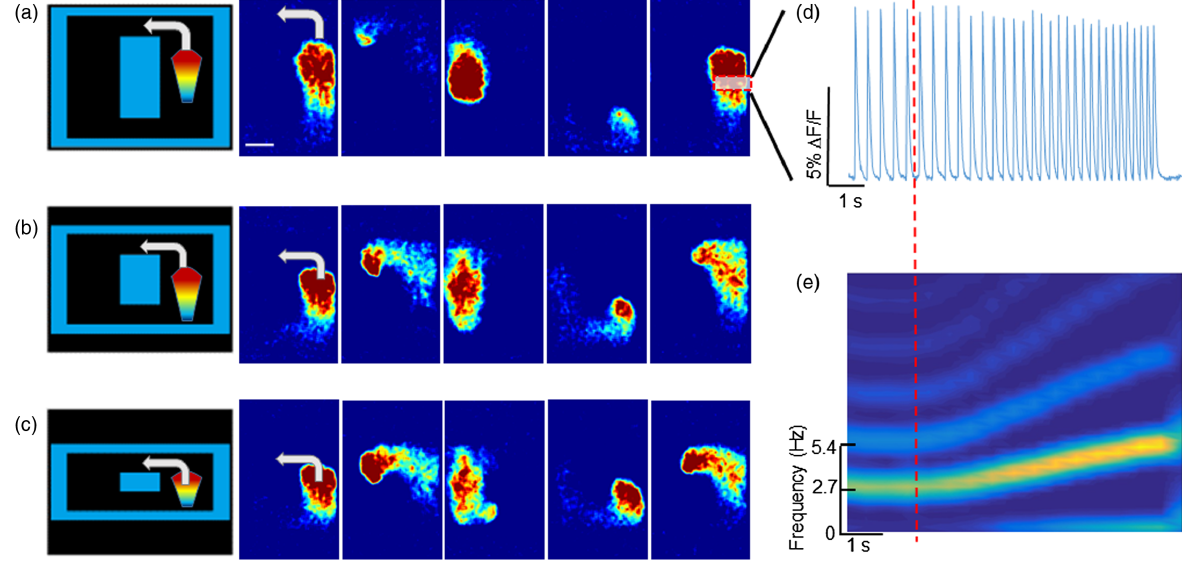
FIG. 4. Dynamic optical tuning of OS-HEK cell oscillators. (a) – (c) Circular wave motion in an optically defined rectangular track, defined by the pattern of blue illumination shown on the left. The boundaries are applied as a quasistatic illumination pattern, and then a directional wave is launched to initiate counterclockwise circulation. The top and bottom optical boundaries are then continuously shrunk during the recording. The apparent decrease in signal amplitude at the top and bottom of the largest pattern arises because the waves passed the edge of the fluorescence excitation spot. Scale bars 1 mm. Movies acquired at 100 Hz, successive panels separated by 8 – 10 frames. (d) QuasAr2 fluorescence from the indicated region. As the vertical dimension of the track shrinks, the oscillations speed up. (e) Spectrogram of the data in (d) showing the increase in frequency with time. See Movie 9 in Supplemental Material